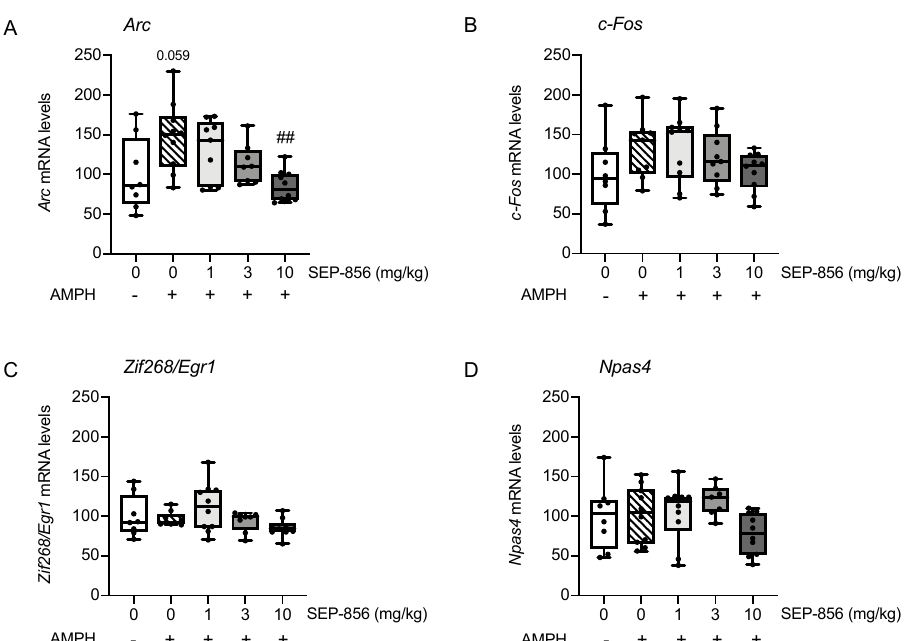
Figure 6. Modulatory activity of acute SEP-856 treatment on IEG changes after AMPH administration. The mRNA levels of Arc ( A ), c-Fos ( B ), Zif268/Egr1 ( C ) and Npas4 ( D ) were measured in the prefrontal cortex of rats pretreated with vehicle or SEP-856 (1, 3 or 10 mg/kg) following the acute injection of AMPH (0.1 mg/kg). The data, expressed as percentage of vehicle-treated rats set at 100%, are represented as box-and-whisker plots of at least seven independent determinations. For each box, the box boundaries indicate the first and third quartiles, the middle line specifies the median and the whiskers represent the lowest and highest values. ## p < 0.01 vs. AMPH-treated rats (one-way ANOVA followed by Tukey post hoc comparison).